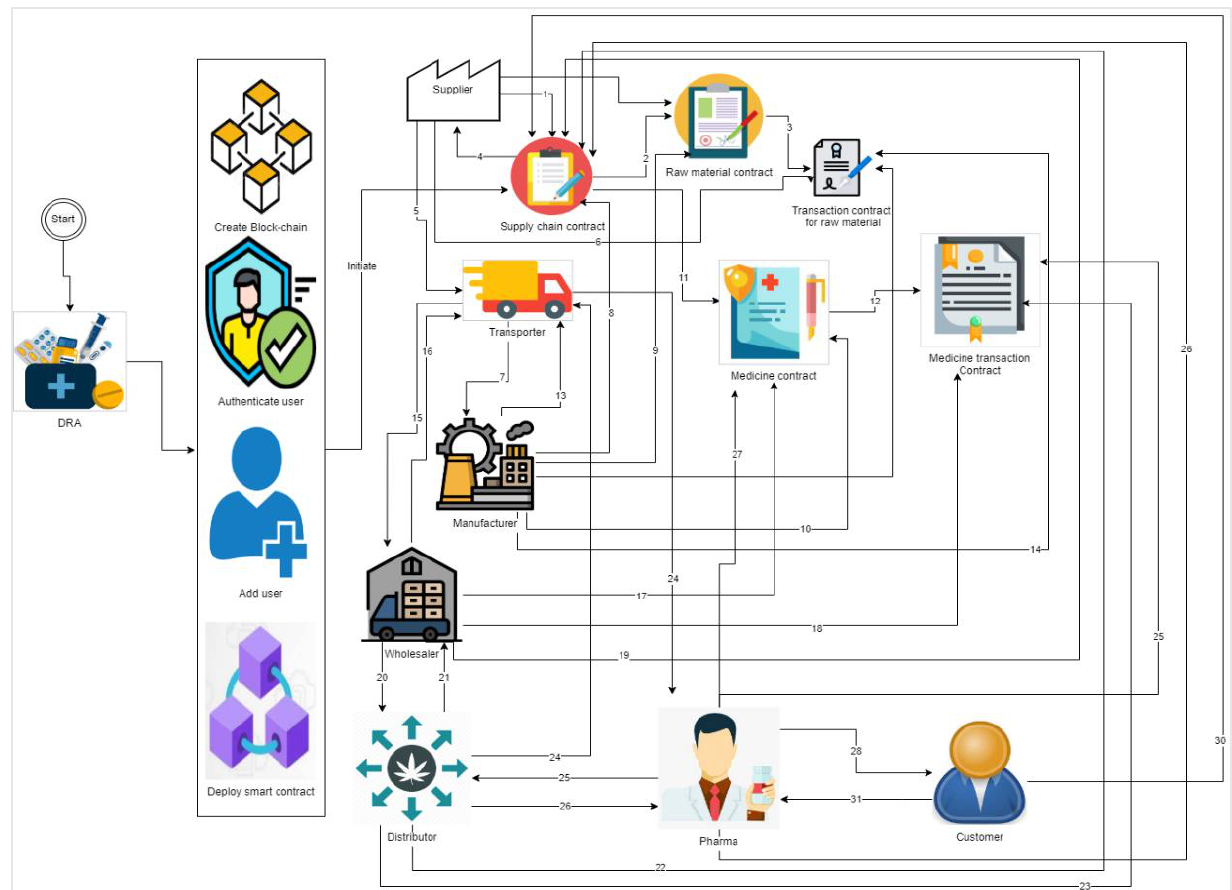
Figure 3 . Proposed framework for handling end-to-end DDP and supply-chain big data . Figure 3. Proposed framework for handling end-to-end DDP and supply-chain big